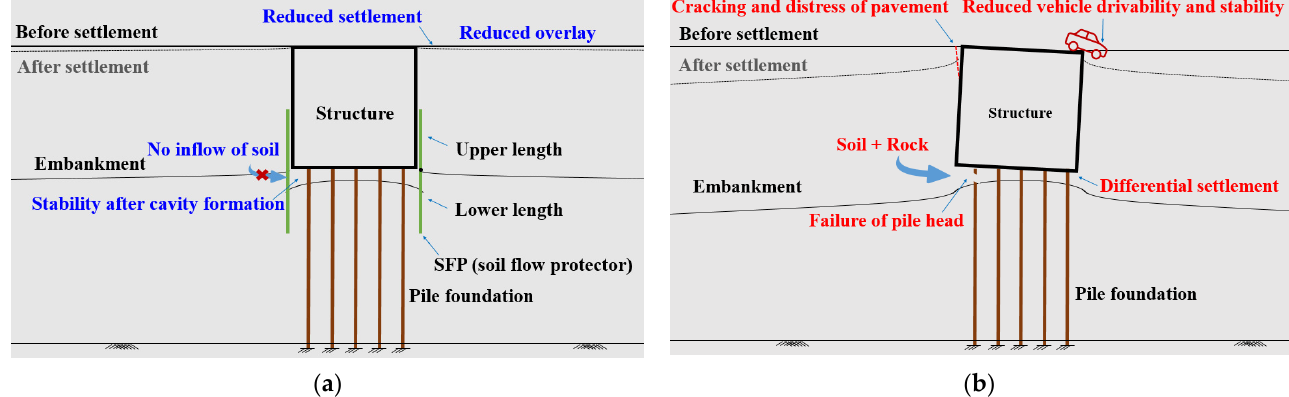
Figure 2. Principle of a soil flow protector (SFP) used to solve problems related to cavity development [9]: ( a ) with SFP; ( b ) without SFP.